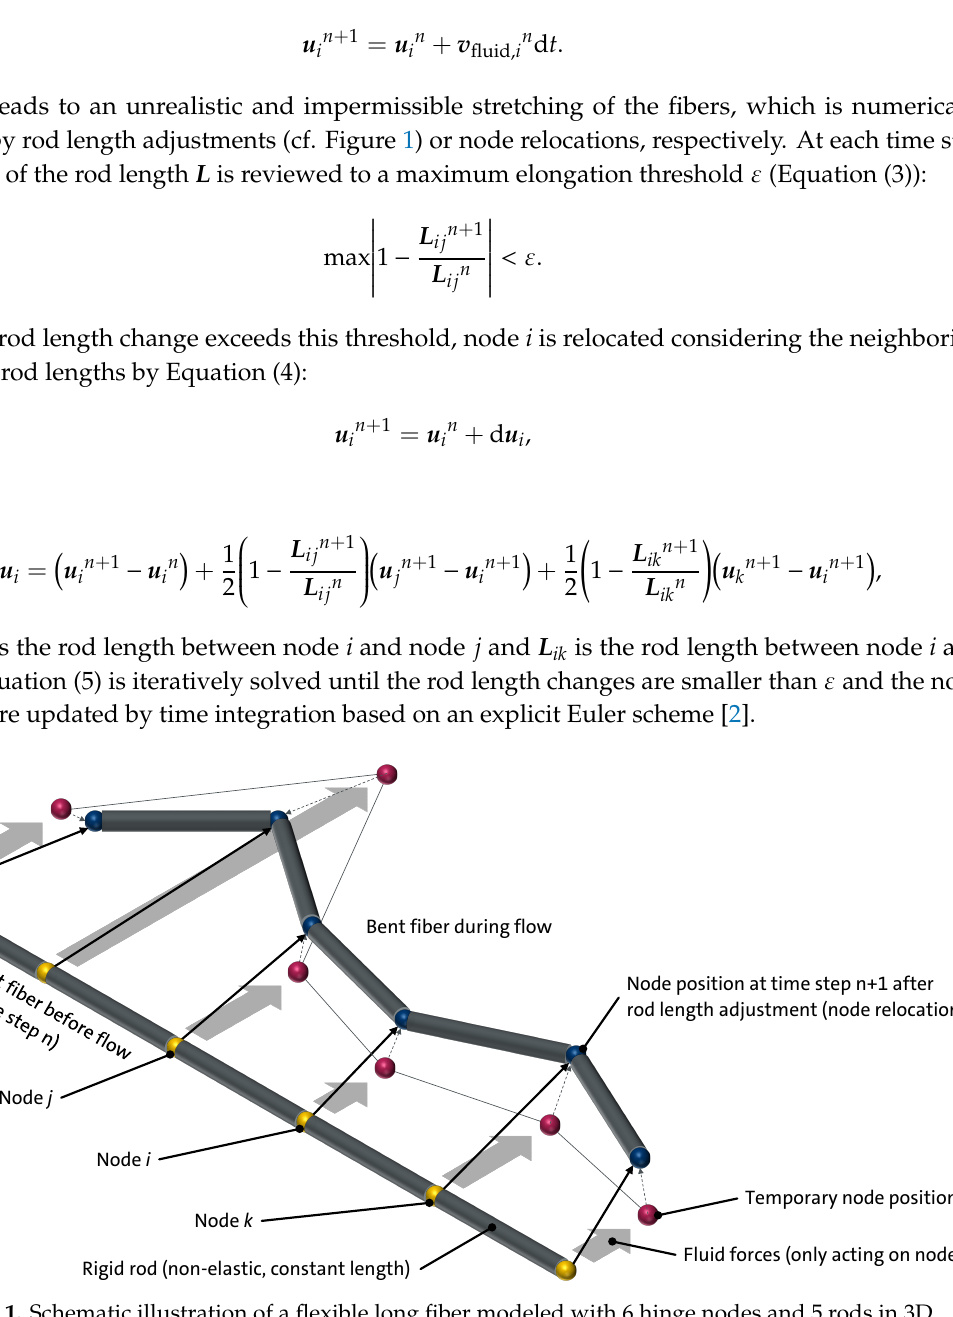
Figure 1. Schematic illustration of a flexible long fiber modeled with 6 hinge nodes and 5 rods in 3D TIMON shown in its initial straight form and bent after moved by fluid forces and applied rod length adjustments (node relocations).